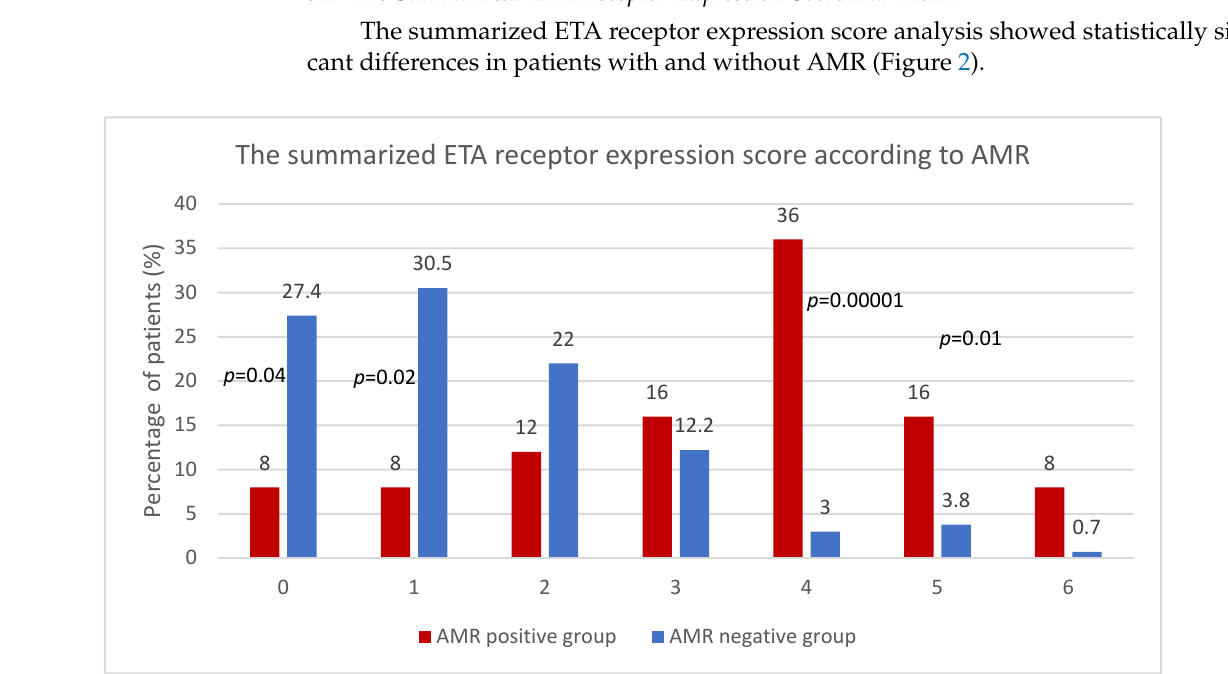
Figure 2. The summarized ETA receptor expression score according to AMR.